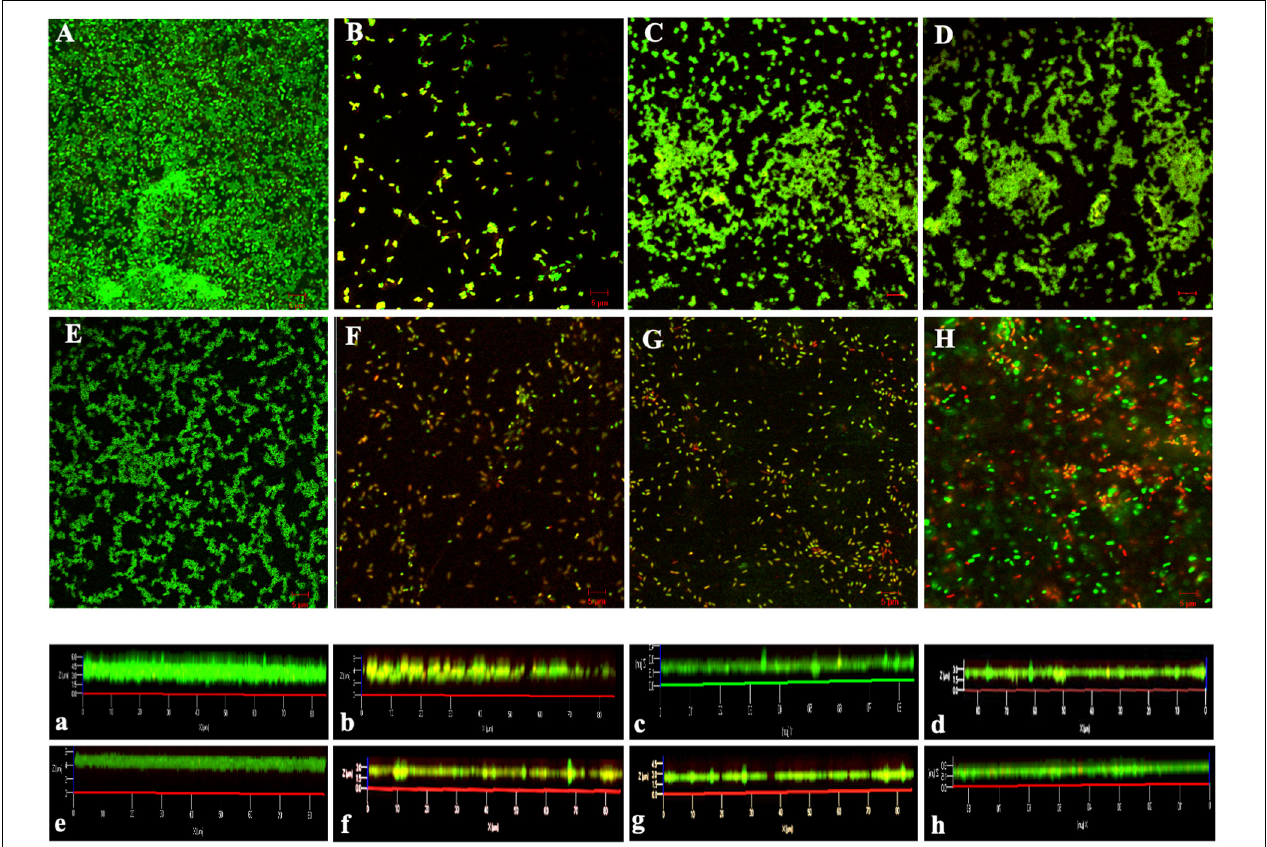
FIGURE 3 | Confocal laser scanning microscopy images of MRPA0108 biofilms. The MRPA0108 cells were incubated at 37 ◦ C for 24 h in the absence (control) and presence of the Trp-containing peptides, respectively, and then stained using a LIVE/DEAD BacLight TM bacterial viability kit. Dead cells are stained red, whereas live cells are stained green. (A) Control; (B) erythromycin; (C–E) 1 × MIC of I1W, I4W, and L5W; (F–H) 2 × MIC of I1W, I4W, and L5W. (a–h) Illustrate an average thickness of biofilms. The micrographs are representative of two independent